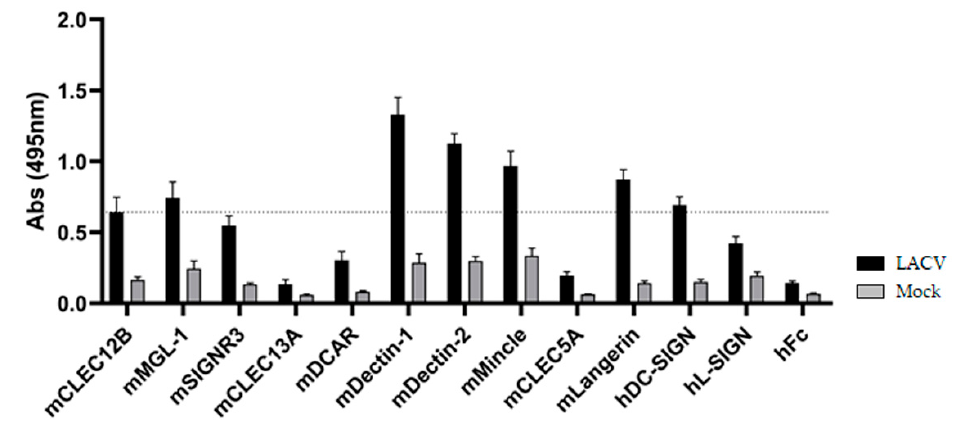
Figure 2. ELISA-based screening of LACV with a C-type lectin receptor (CLR)-hFc fusion protein library. DC-SIGN was reported to recognize Gc/Gn of LACV [23] and is considered a positive control. To discard possible false-positives, a 3-fold margin in the absorbance value relative to hFc (negative control) was given (dotted line), based on previous screenings with the CLR-hFc library [27]. Data depicted are the mean ± SEM of four independent experiments (duplicates each).